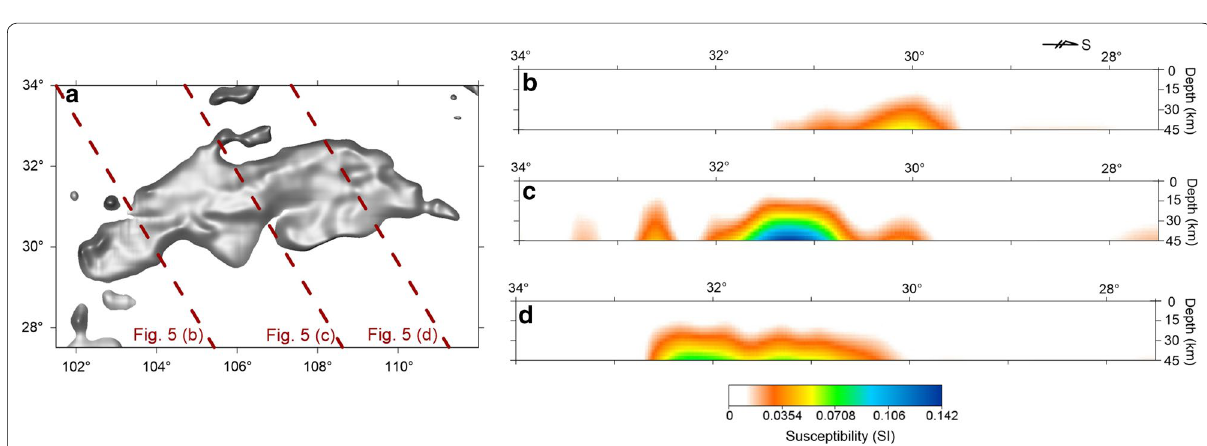
Fig. 5 Vertical slices of the inverted susceptibility model. a 3D display of the inverted model with an iso-surface of high susceptibility viewed from the top. b – d Three vertical slices perpendicular to the main trending of the magnetic anomaly. The locations of these vertical slices are shown by red dashed lines in